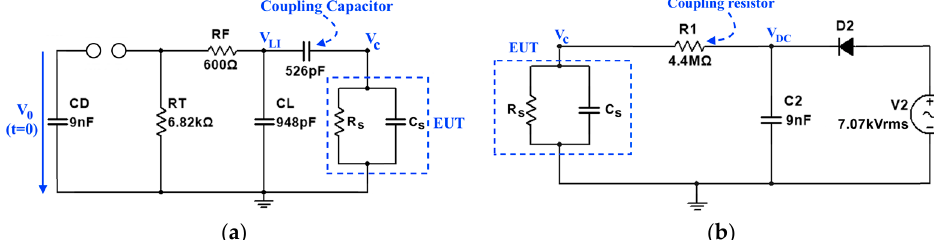
Figure 4. ( a ) The equivalent circuit of LI voltage side; ( b ) The equivalent circuit of DC voltage side.